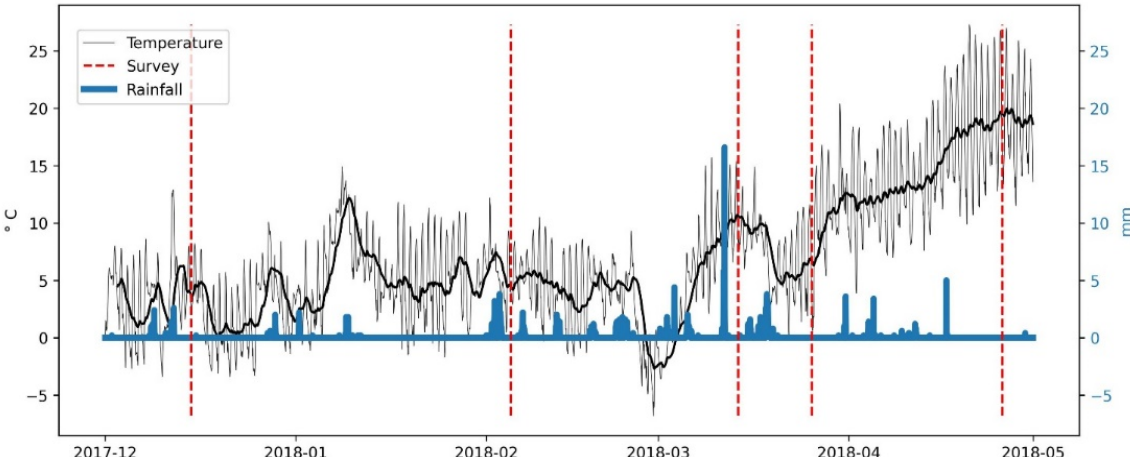
Figure 3. Time series of rainfalls [mm] and air temperatures [ ◦ C] from the weather station (December 2017–May 2018). The solid black line shows daily mean temperature values. The dashed red lines show the time of ERT and EMI surveys.